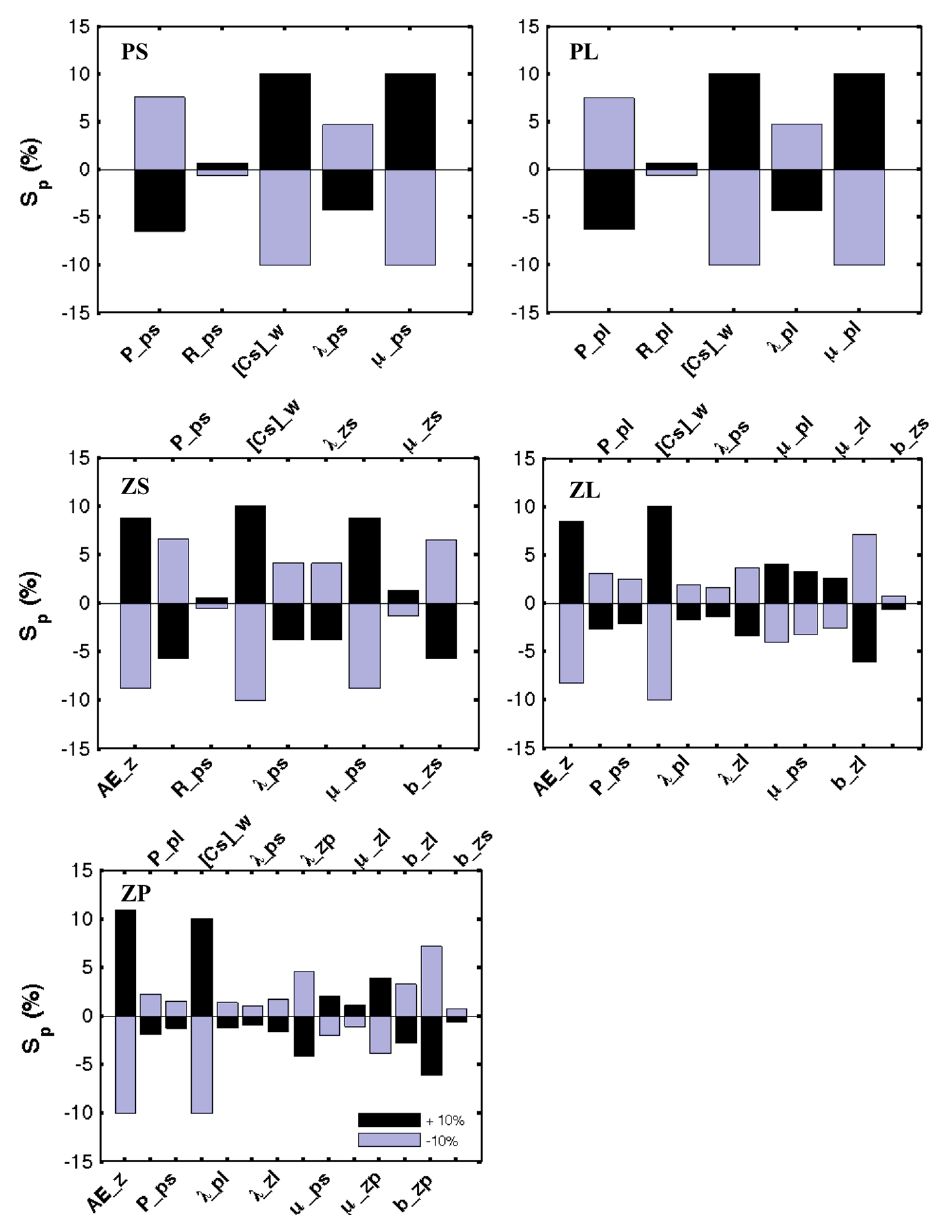
Figure 4. Sensitivity ( S p ) of the estimated 137 Cs concentrations in different plankton groups (PS, PL, ZS, ZL, ZP) to a 10% change in the parameters of Eqs. (3) and (7). The S p values are calculated using Eq. (8). Significance of parameters: P _: primary production rate, R _: phytoplankton respiration rate, [Cs]_w: 137 Cs concentration in seawater, λ _: depuration rate, µ _: accumulation rate, AE_: Assimilation efficiency, b : growth efficiency of